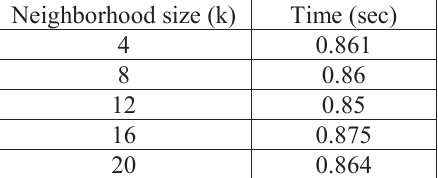
Table 4. Neighborhood size vs time